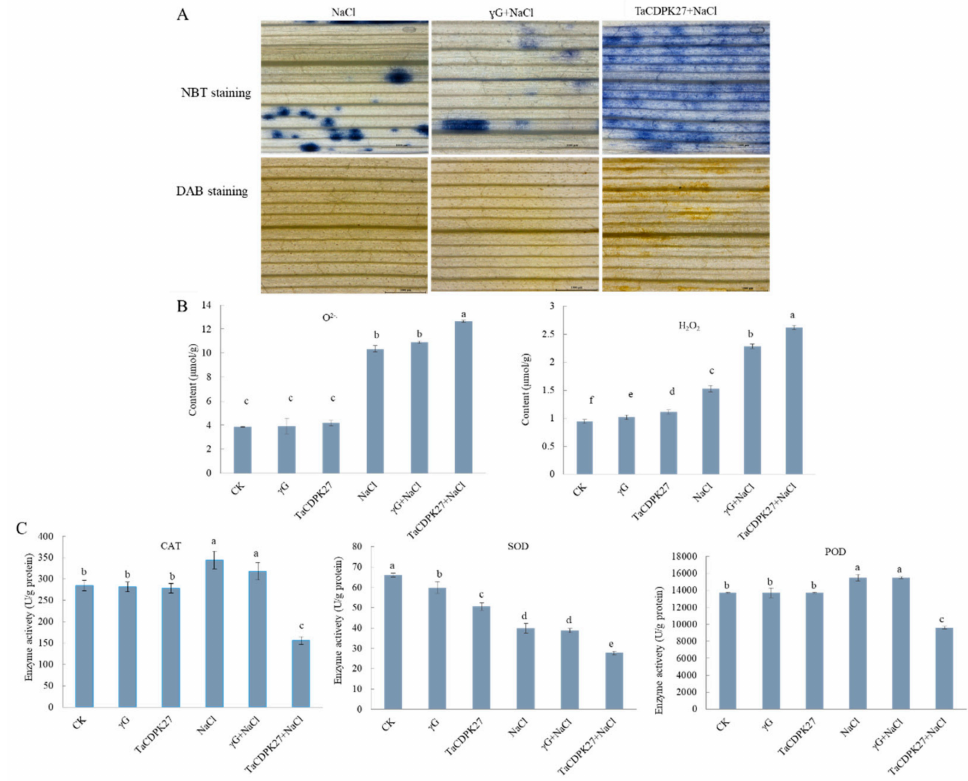
Figure 8. The effect of silencing of TaCDPK27 on the ROS accumulation in leaves of wheat seedlings under NaCl treatment. ( A ) NBT staining of the generation and accumulation of O 2 − . in leaves of wheat seedlings. DAB staining of the generation and accumulation of H 2 O 2 in leaves of wheat seedlings. ( B ) The content of O 2 − . and H 2 O 2 in leaves of wheat seedlings. ( C ) The activities of POD, SOD, and CAT in leaves of wheat seedlings. Standard deviations are shown ( n > 3, ± SD, p < 0.05). CK was from wild-type wheat seedlings, γ G was from BSMV-VIGS-GFP-inoculated wheat seedlings, TaCDPK27 was from BSMV-VIGS-TaCDPK27-inoculated wheat seedlings. The different letters in each treatment show the significant difference ( p < 0.05). All the experiments presented here were performed at least three times, and similar results were